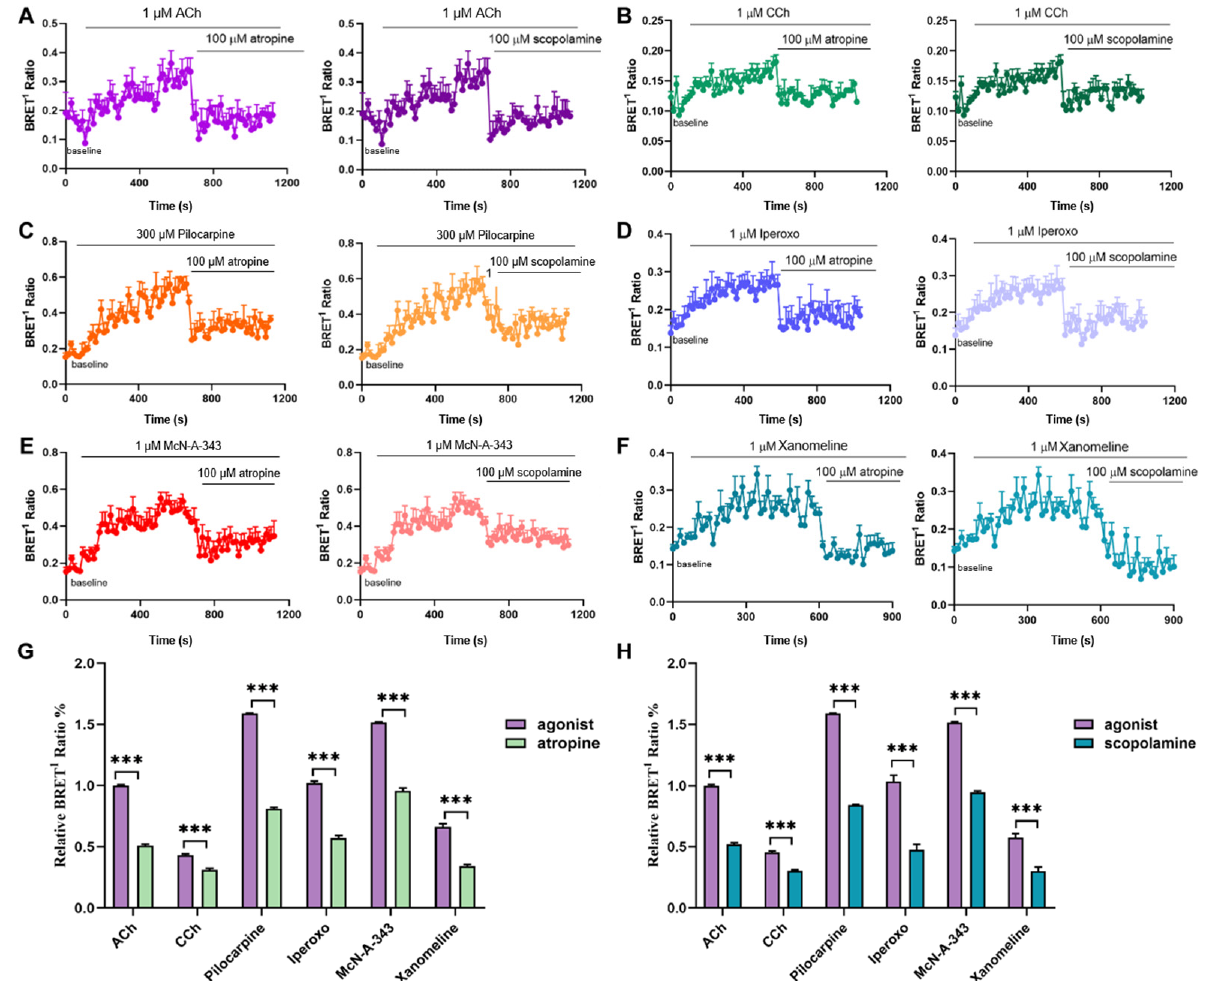
Figure 5. Analysis of antagonist e ff ects on β -arrestin2-M1mAChR binding by BRET. ( A ) ACh, ( B ) CCh, ( C ) Pilocarpine, ( D ) Iperoxo, ( E ) McN-A-343, ( F ) Xanomeline, ( G ) antagonistic potency of Atropine to agonists, and ( H ) antagonistic potency of Scopolamine to agonists. Data are means ± S.E.M. of 3–8 independent experiments performed in duplicate. The statistical signi fi cance of di ff erences between the indicated groups was assessed by two-way ANOVA, where *** p < 0.001.